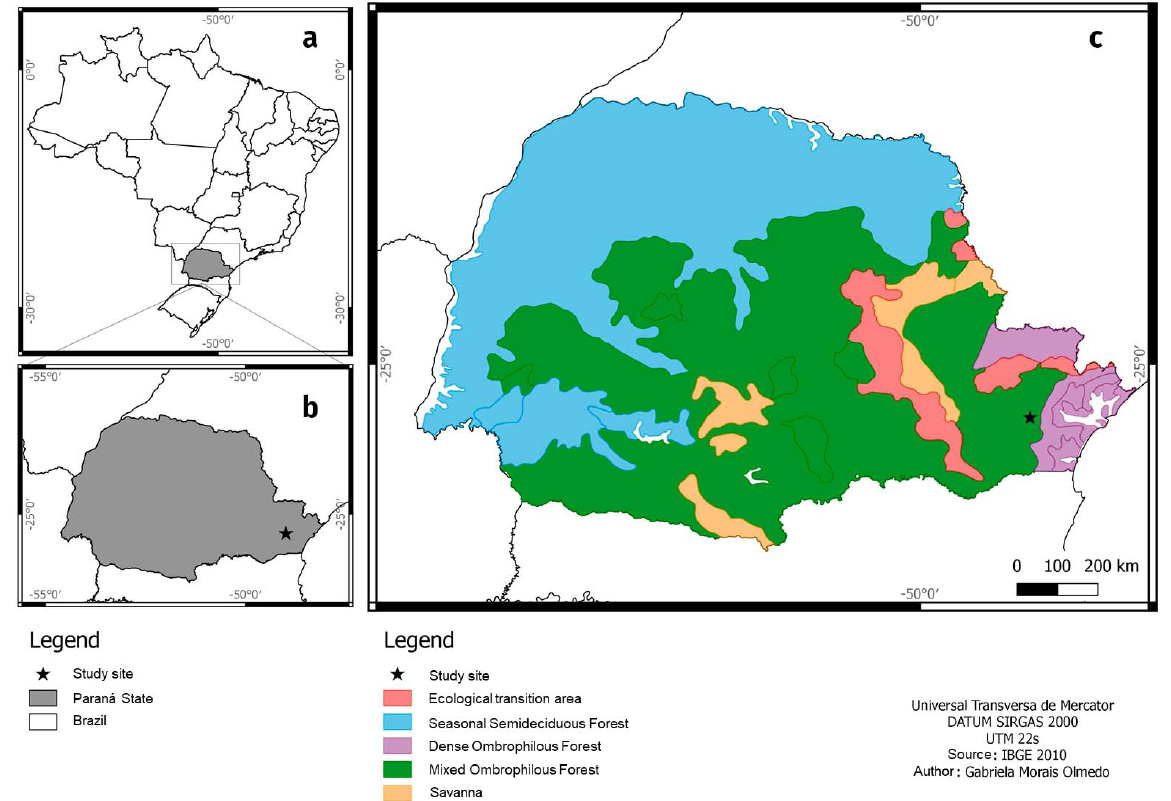
Figure 1. Location of the study area. a: Map of Brazil highlighting the state of Paraná; b: Map of the state of Paraná highlighting the study area; c: Map of the state of Paraná highlighting the physiognomy of